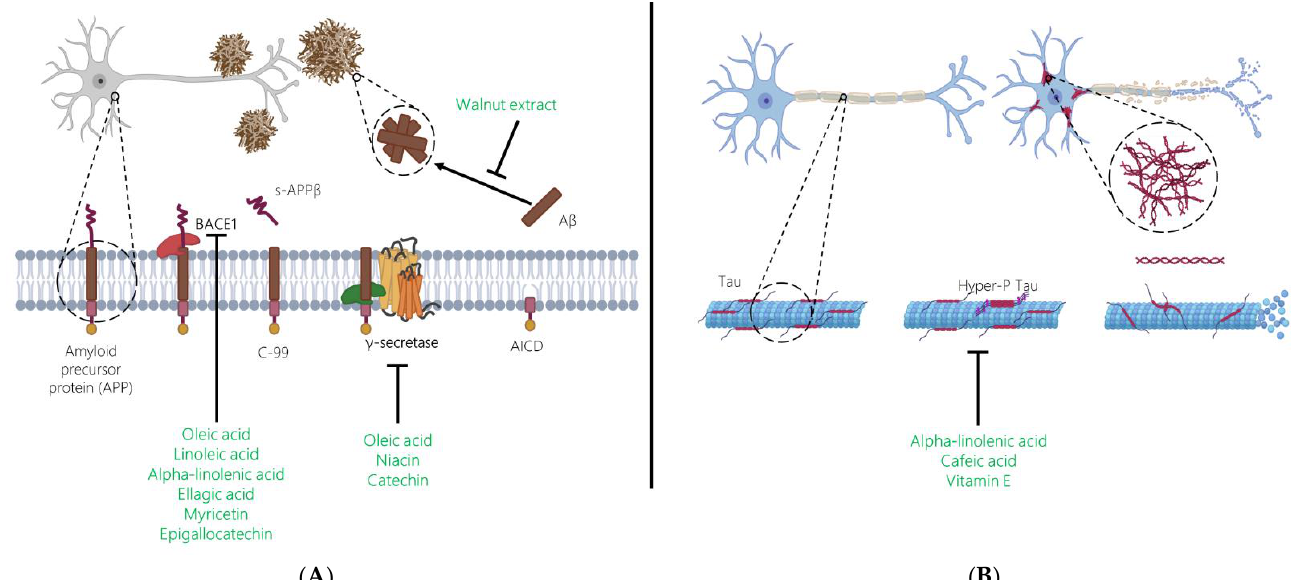
Figure 1. Alzheimer´s Disease Hallmarks ( A ) amyloid- beta (Aβ) deposition and ( B ) neurofibrillary tangles of hyperphosphorylated tau. Effects of nut bioactives on critical pathways are shown 4.1.3. Potential of Aβ Biomarkers in Future Research on the Neuroprotective Properties